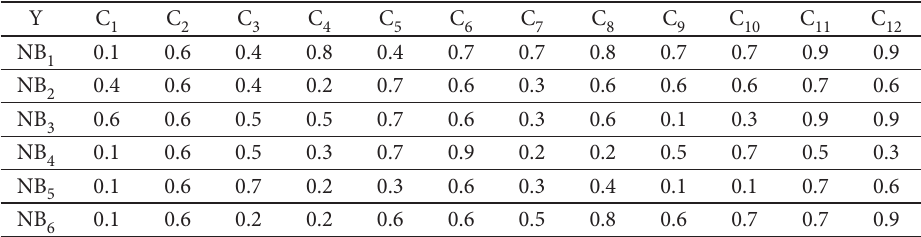
Table 6. Necessary conditions to start a new business in a sports